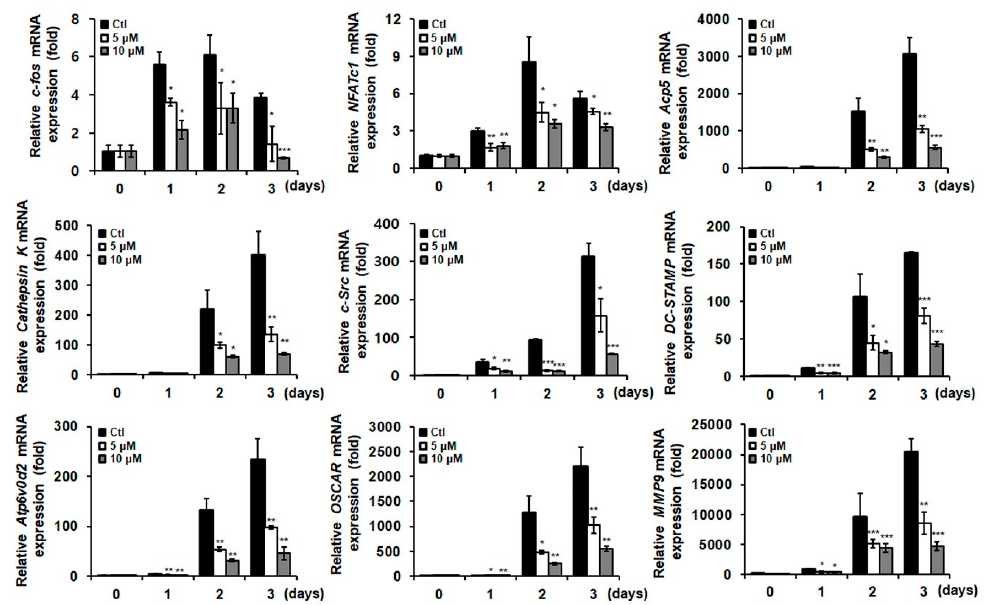
Figure 2. NAPMA inhibits the expression of osteoclast-specific genes. qPCR analysis of the expression of osteoclast-specific genes, c-Fos, NFATc1, Acp5, cathepsin K, c-Src, DC-STAMP, Atp6v0d2, OSCAR, and MMP9 in BMMs stimulated with RANKL for three days in the presence of NAPMA. The data presented are the mean ± SD of three independent experiments. * p < 0.05, ** p < 0.01, and *** p < 0.001 compared with the control group (treated RANKL but without NAPMA).